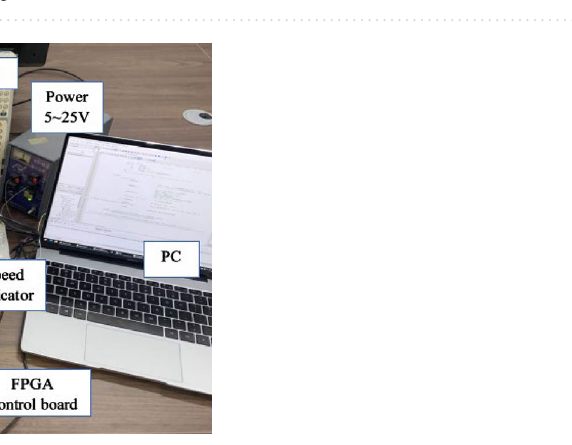
Figure 15. The comparison of speed response under the mechanical parameters variation conditions: ( a ) Resistance ( b ) Inductance ( c ) Flux linkage ( d ) Inertia.